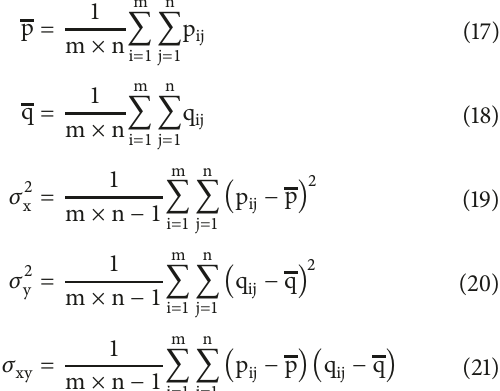
Table 3 notes the results of seven-way PVD [18] which is an extension of Wu and Tsai’s [1] technique. Table 4